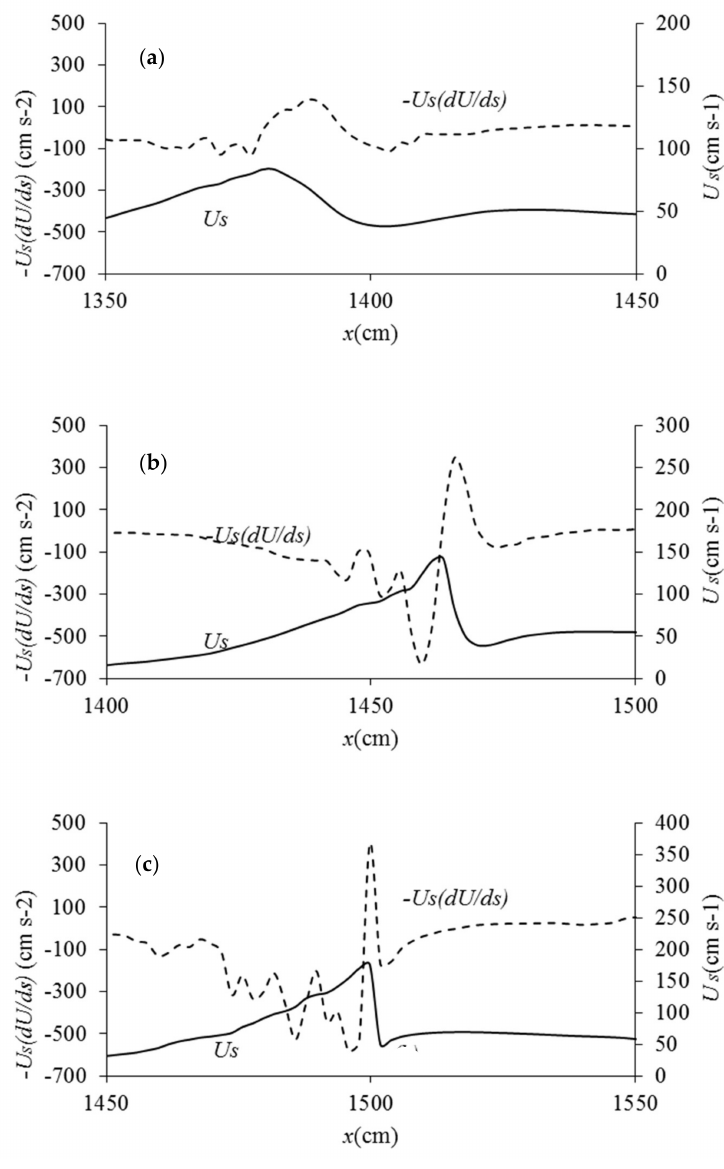
Figure 10. Free surface velocity and deceleration term ( a ) before, ( b ) during and ( c ) after breaking for reach